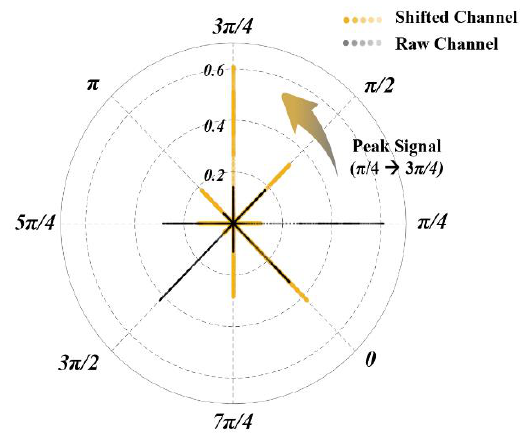
Figure 4. Polar scatter of every sampling point in each sensing channel on 8 polar axes. Raw channel is transformed to shifted channel according to maximum channel amplitude.